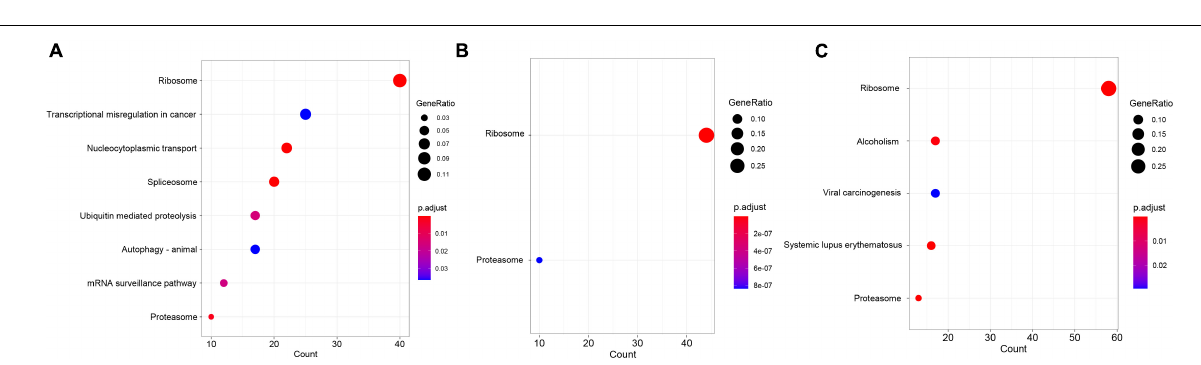
FIGURE 3 | Intersection of biological processes in GO enrichment results of differentially expressed genes at different low temperatures. (A,B) Represented the intersection of biological processes results of up-and down-regulated DEGs, respectively.